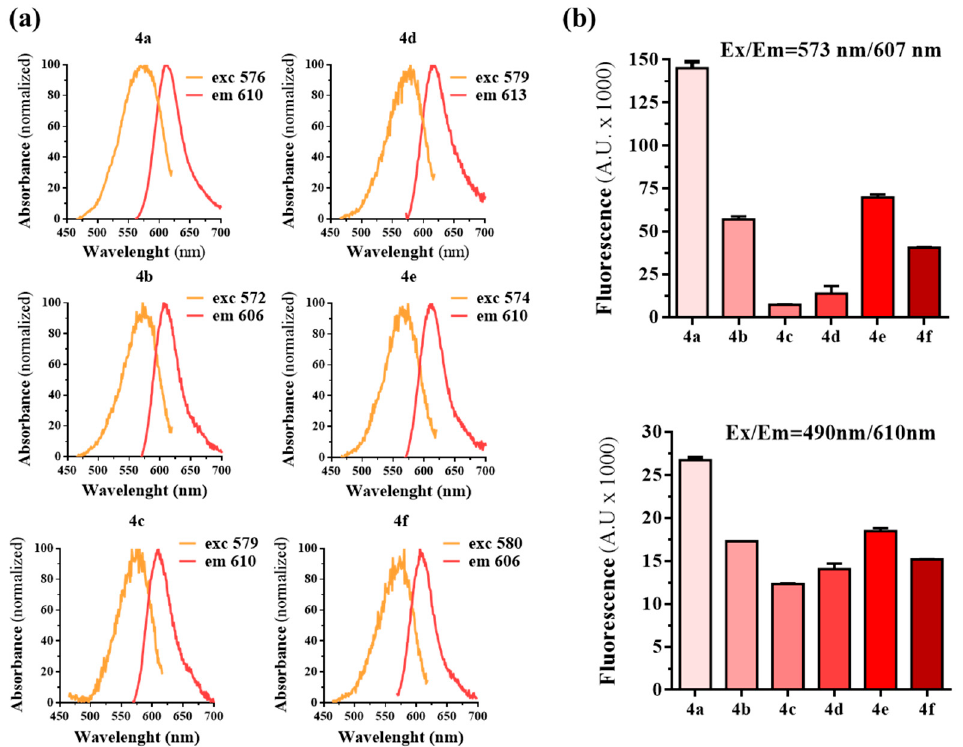
Figure 3. Characterization of the fluorescent properties of conjugates 4a – f . ( a ) Excitation and emission spectra of the mGlu 5 R fluorescent ligands 4a – f . The excitation / emission wavelength peak for each compound is shown in nanometers. ( b ) Fluorescence emission (arbitrary units, A.U.) at 607 nm or 610 nm is shown after exciting (573 nm or 490 nm, respectively) the six BODIPY-conjugates (10 µ M solution in 0.05% DMSO of 4a to 4f depicted as light to dark red columns). This value is related to the quantum yield of each fluorophore.